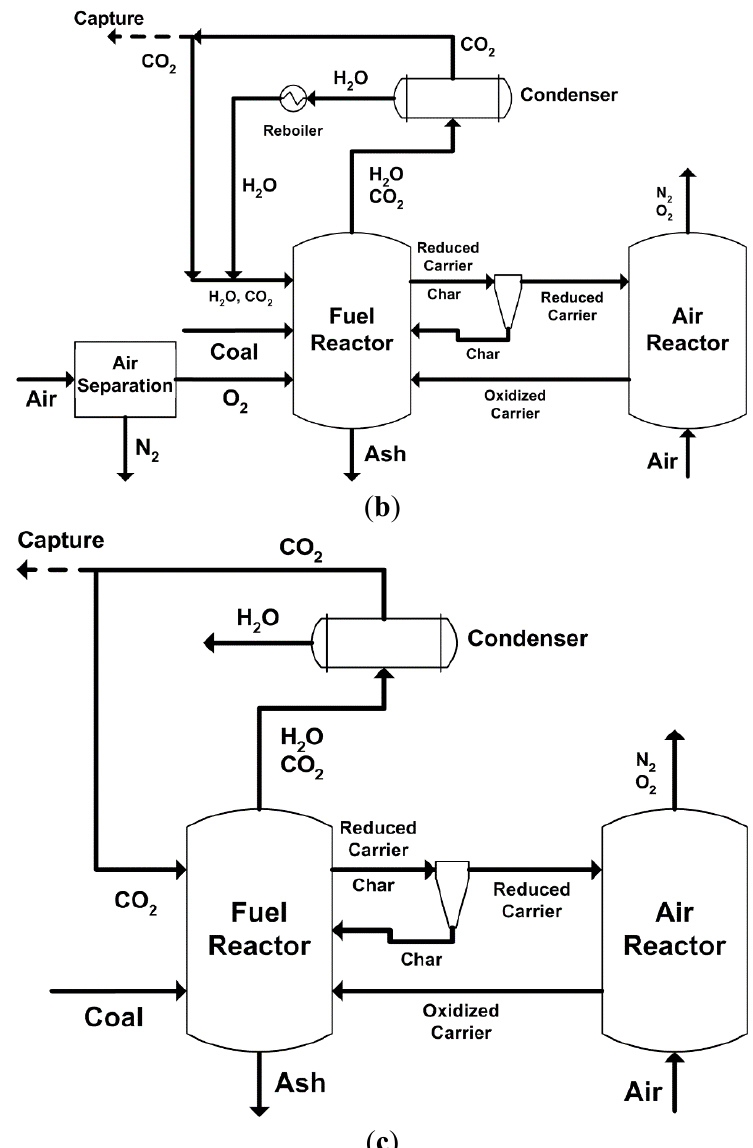
Figure 2. Major reaction processes of solid fuels in chemical-looping combustion (CLC): ( a ) Syngas-CLC; ( b ) in situ gasification CLC (iG-CLC); and ( c ) CLC with oxygen uncoupling (CLOU)